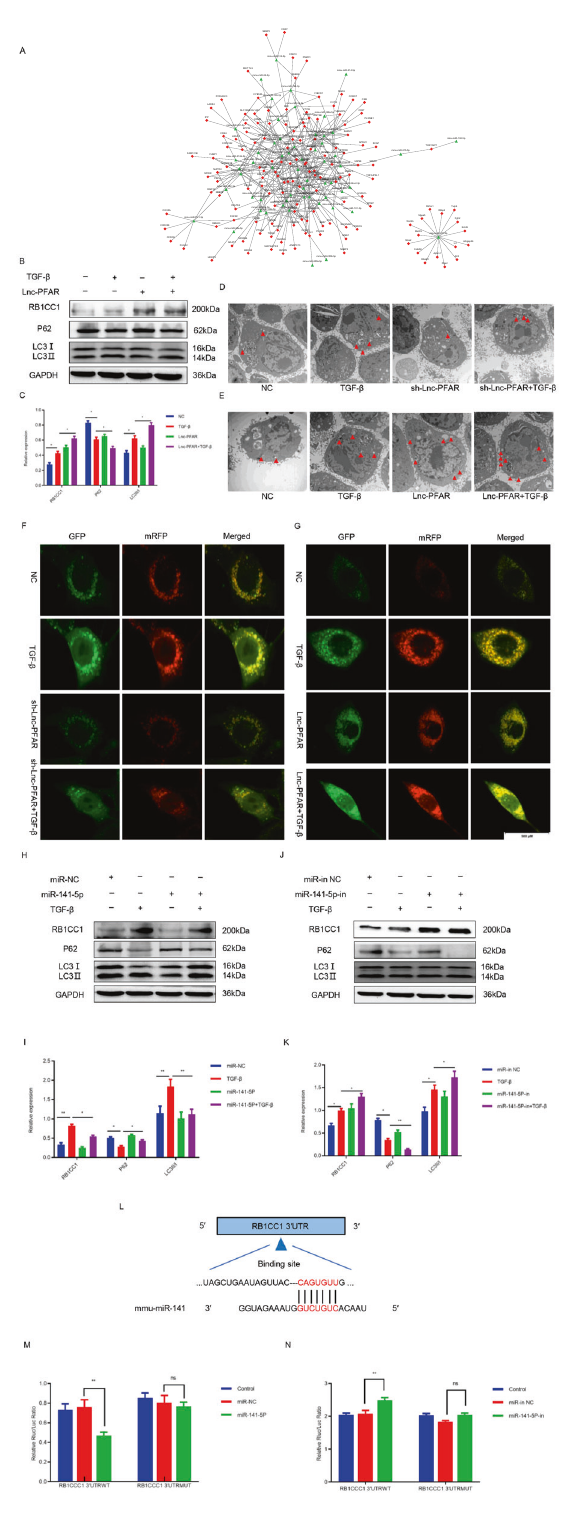
in a mouse model (Fig. S5A). The expressions of Lnc-PFAR, miR- 141-5p, and pre-miR-141 in pancreatic tissues were detected. Inhibition of Lnc-PFAR impaired the level of pre-miR-141 and improved miR-141-5p expression. The opposite results were con fi rmed in Lnc-PFAR-upregulated groups (Fig. 5A – F, Fig. S5B – G). We then explored the relative expressions among Lnc- PFAR, miR-141-5p, and pre-miR-141, and no correlation was found